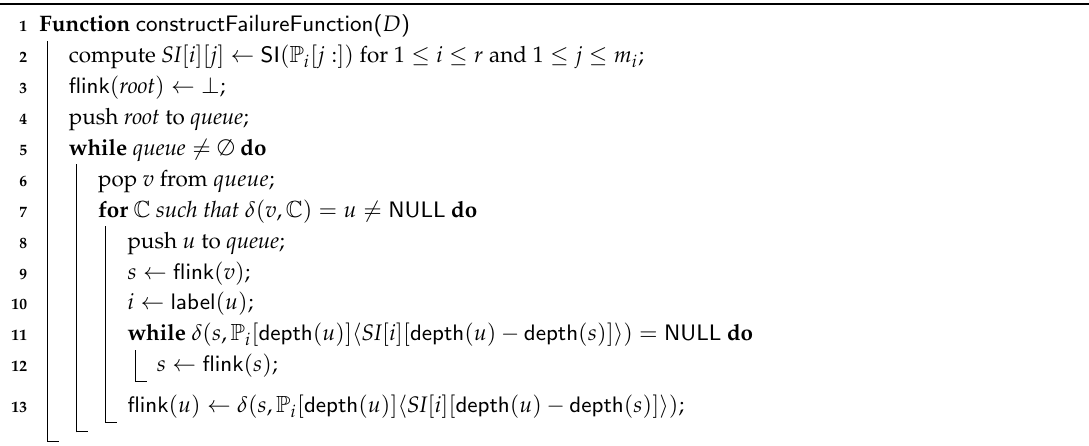
Algorithm 4: Multi-track AC-automaton failure function construction